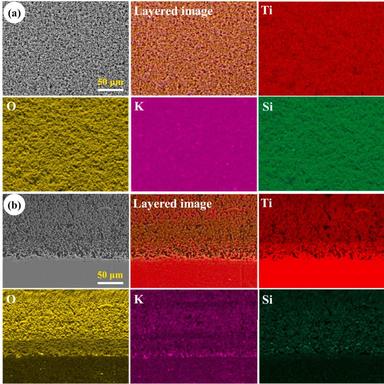
(a) Surface and (b) cross-sectional morphologies and the corresponding EDS mappings of the TiO2 coating after sintering at 1000 ◦C for 1 h.